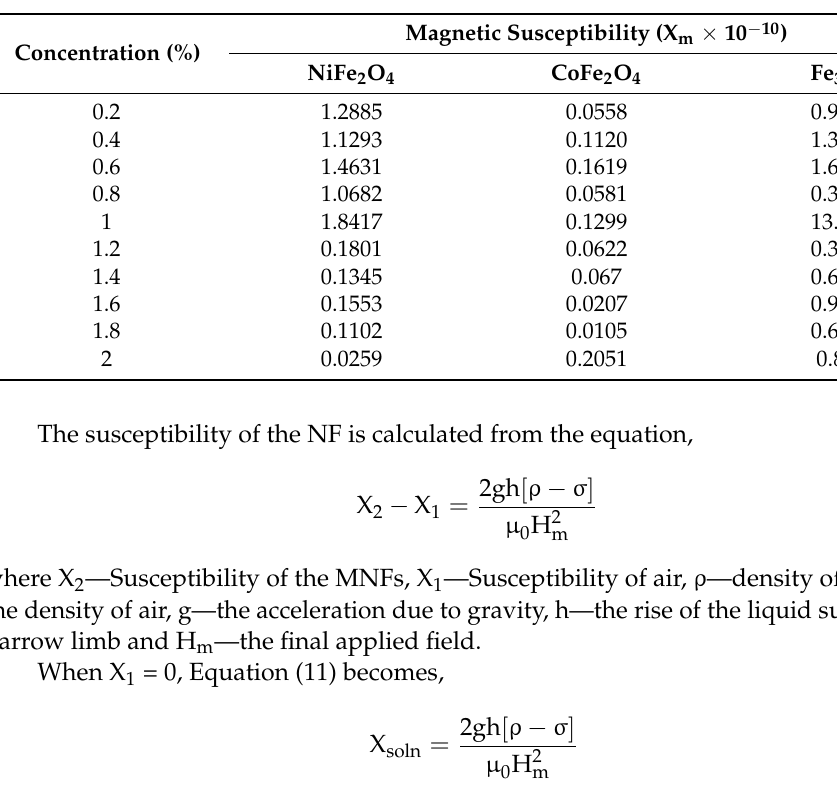
Table 4. Variation of magnetic susceptibility of magnetic NFs with